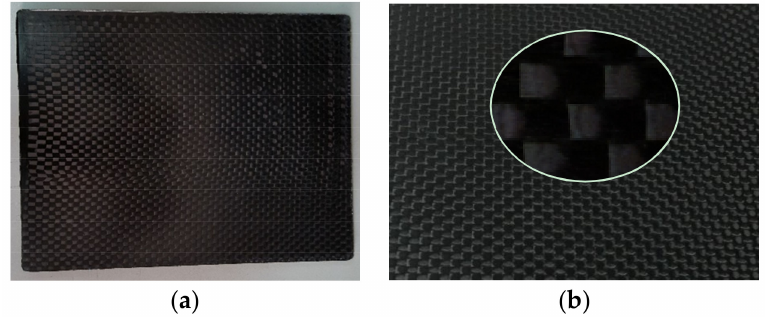
Figure 7. Specimen’s photo ( a ) and surface morphology contrast ( b ) of the composites prepared by CM process.